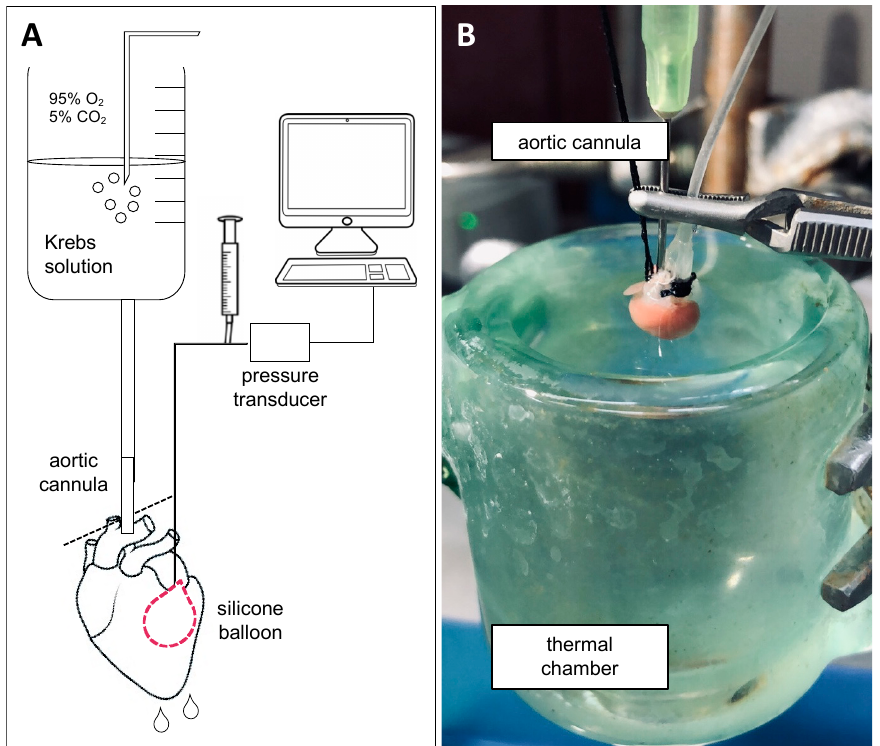
Figure 1. Mouse heart on a Langendorff perfusion system. ( A ) Schematic representation and ( B ) photograph of the cannulated heart. The isolated heart is cannulated via the aorta in order to be perfused with oxygenated, nutrient-rich Krebs solution. A balloon, connected to a pressure transducer, is inserted in the left ventricle for myocardial function measurements. To maintain 37 °C, the heart is immersed in a thermal chamber containing Krebs solution during the entire ex vivo procedure.